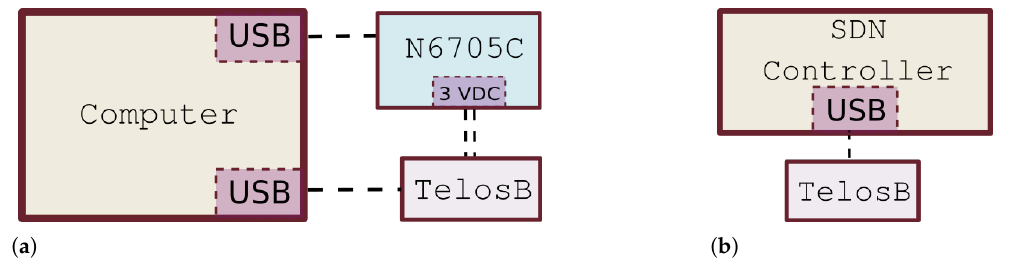
Figure 3. Connection diagrams for ( a ) energy consumption measurement using the N6705C of Keysight and ( b ) the SDN controller and TelosB